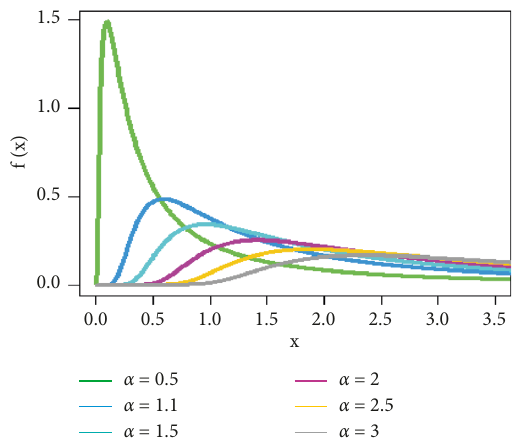
Figure 1: Different PDF plot for INH distribution when scale parameter λ �